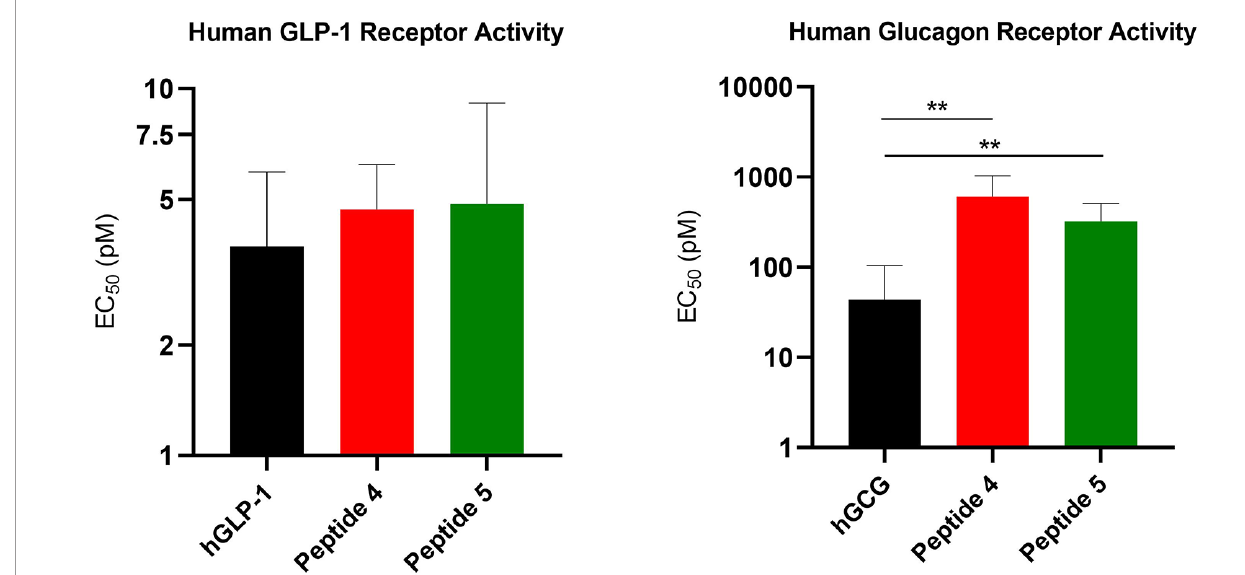
FIGURE 3 | The in vitro bioactivity assessment of peptides 4 and 5. Assays were conducted with BHK cells that over-express either the human GLP-1 or glucagon receptors. Left panel, human GLP-1 receptor where native GLP-1 has a determined EC 50 of 3.72 +/- 2.21 pM (n=6), and peptides 4 and 5 are 4.68 +/- 1.53 pM (n=6) and 4.85 +/- 4.29 pM (n=6), respectively (no statistical signi fi cance between human GLP-1, peptide 4, and peptide 5, using the Student ’ s unpaired t-test analysis). Right panel, human glucagon receptor where native glucagon has an EC 50 of 43.8 +/- 60.41pM (n=6) and peptides 4 and 5 are 607.1 +/- 428.3 pM (n=6) and 323.0 +/- 186.6 pM (n=6), respectively (P < 0.01 between hGCG and peptide 4, P < 0.01 between hGCG and peptide 5, no statistical signi fi cance between peptide 4 and peptide 5, using the Student ’ s unpaired t-test analysis). **P <